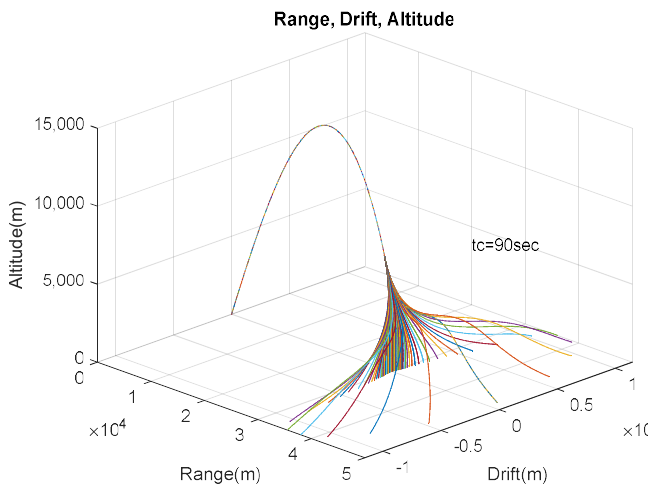
Figure 8. Control Activated at 90 s.